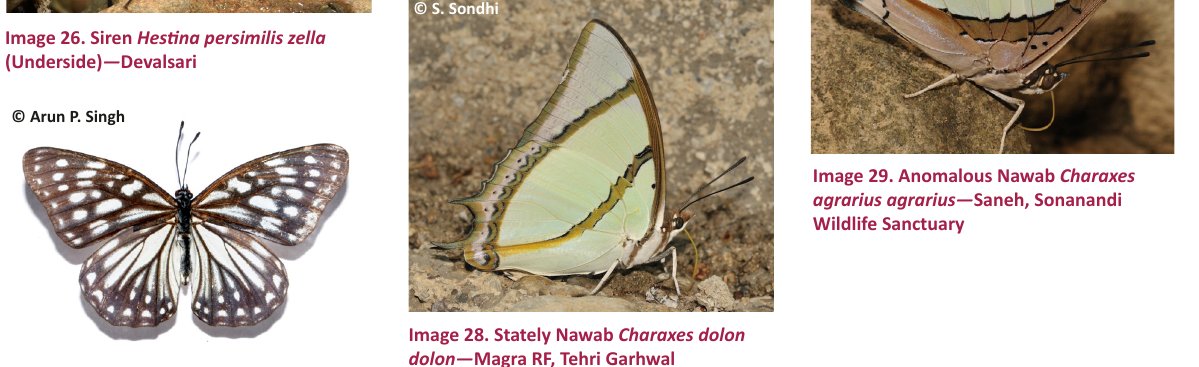
Image 27. Siren Hestina persimilis zella (Upperside) — Maldeota, Dehradun Valley